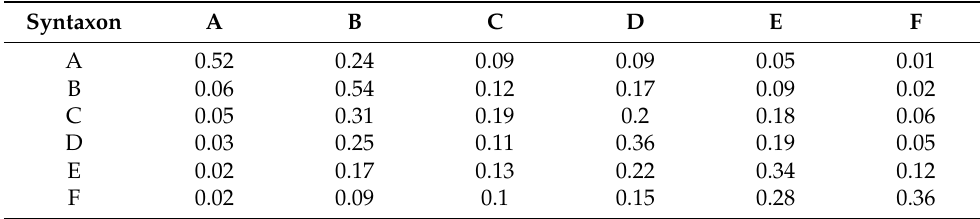
Figure 7. Quantitative circular graph of PAC network in the forest community of the study site. The circle’s size is proportional to the species’ abundance in the syntaxon; the red circles represent the apparent competition within syntaxon, and blue line presents the apparent competition among the syntaxa. Table 3. PAC values in the network of syntaxa.